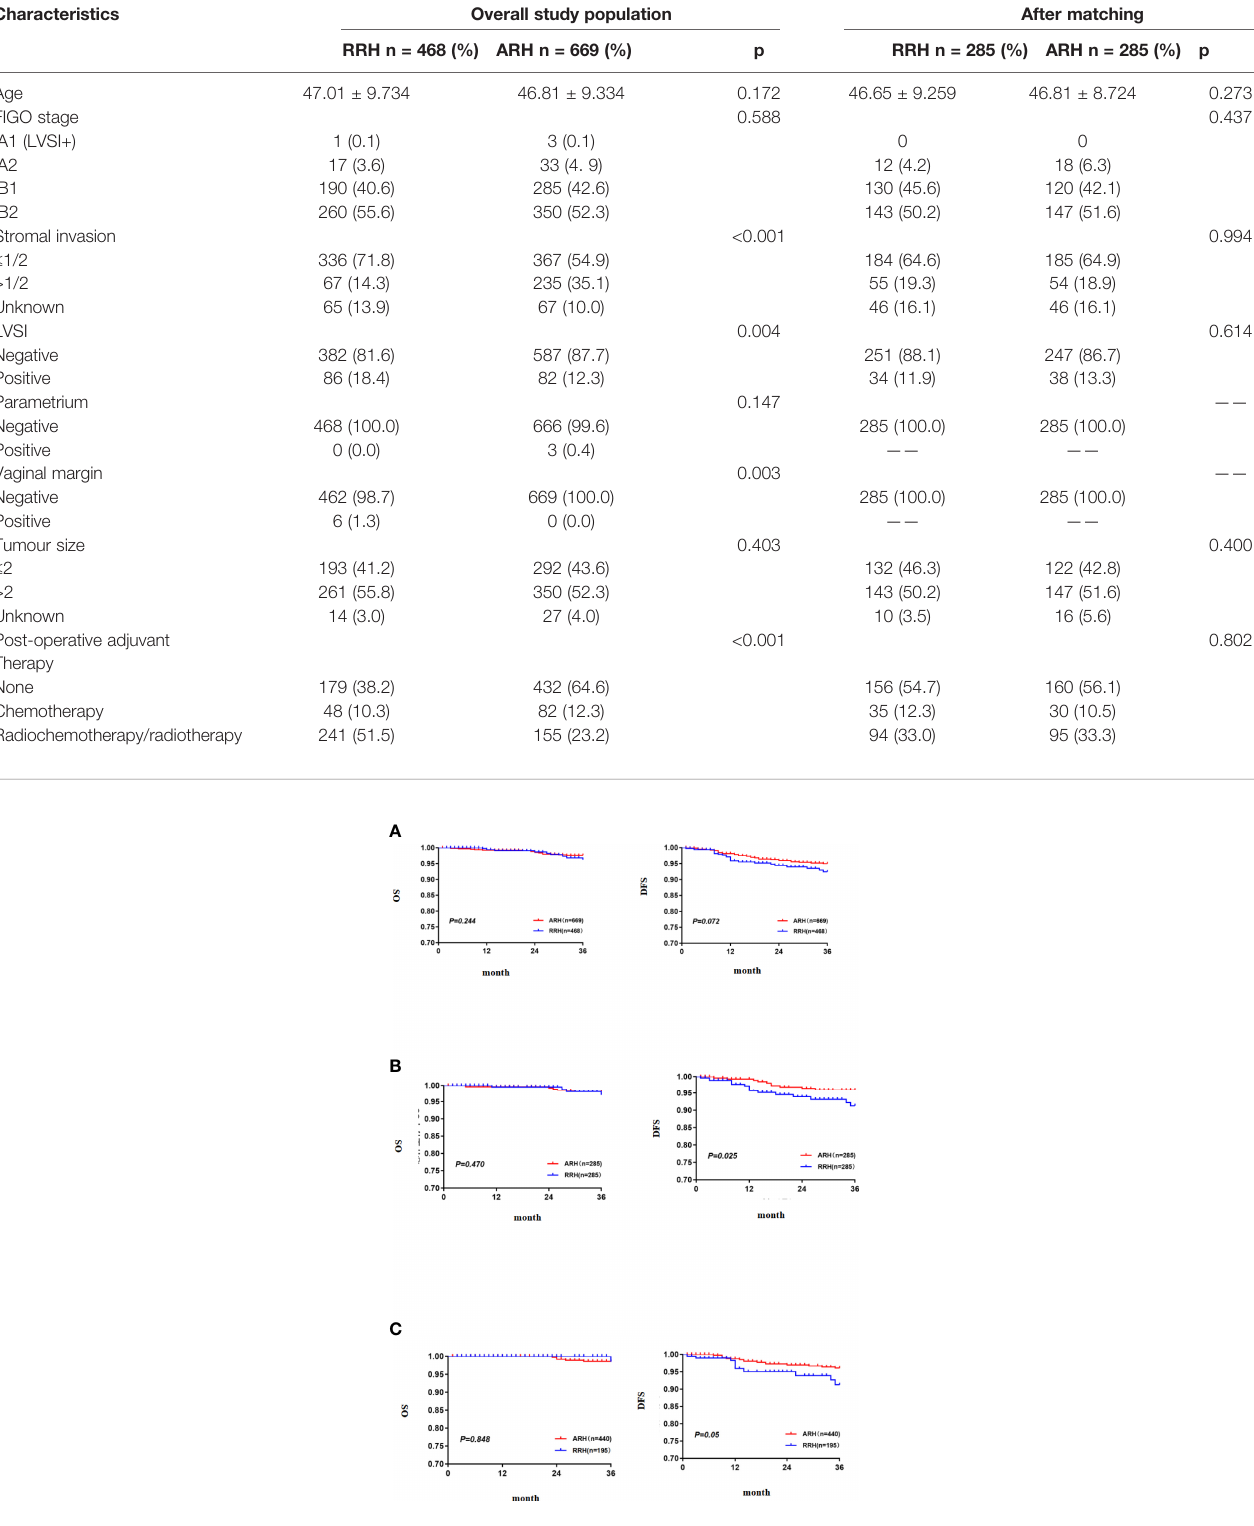
TABLE 1 | The clinicopathologic characteristics of patients in the RRH group and ARH group. Characteristics